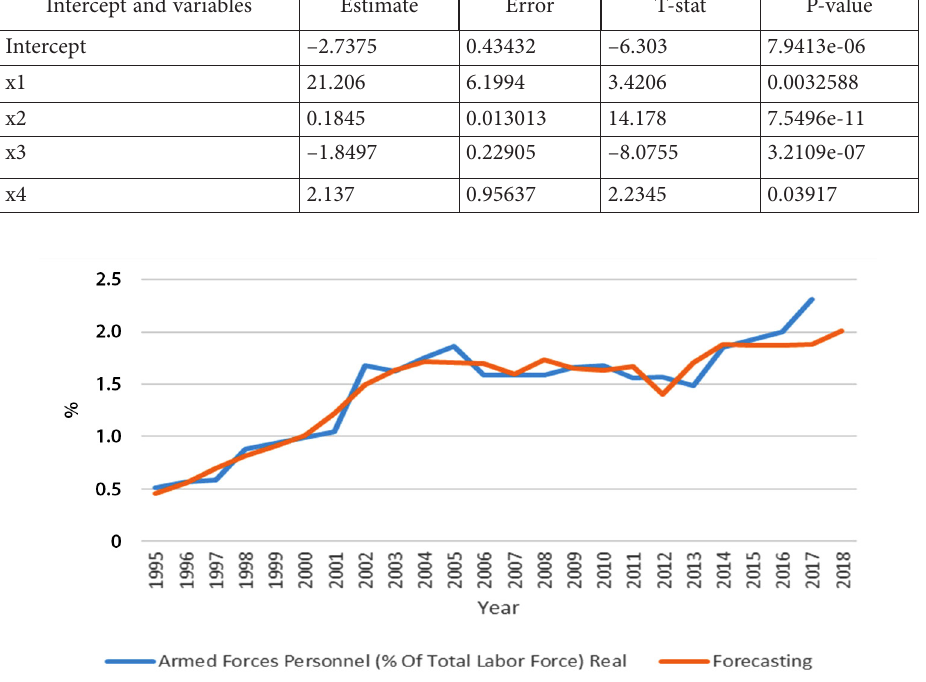
Table 3. Equation estimated coefficients (source: authors‘ calculation) Intercept and